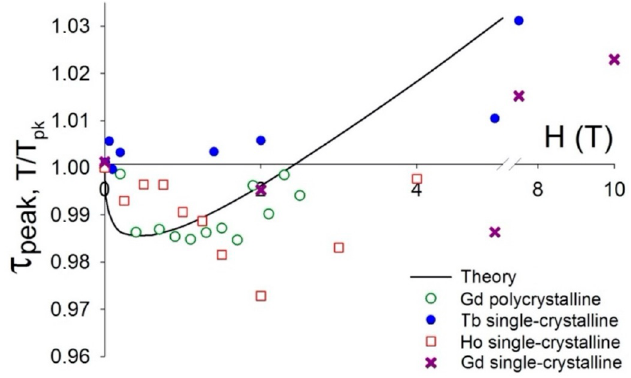
Figure 4. Position of the maximum in the magnetic heat capacity of gadolinium, terbium and holmium versus the applied magnetic field (Tesla). Theory [312] is compared to experimental data for Gd [38], Tb [313], and Ho [314].